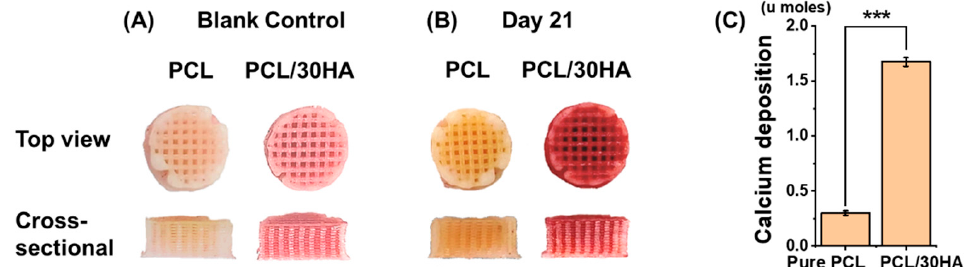
Figure 6. Mineralization assessment of HOB cells cultured in the 3D printed PCL-based scaffolds for up to day 21 using Alizarin red S assay. Qualitative assessment was shown with images of top and cross-sectional views of Alizarin red staining on the blank control ( A ) and HOB seeded scaffolds after 21 days of culturing ( B ). ( C ) Quantitative assessment of calcium deposition in HOB seeded PCL-based scaffolds. The results are reported as u moles per well/scaffold (*** p < 0.001).